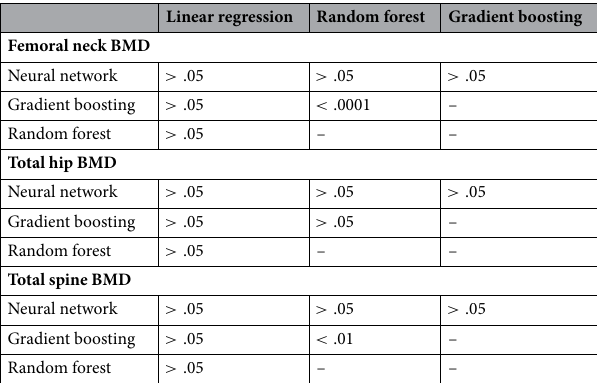
Table 2. Statistical comparisons of mean square errors in the testing dataset ( n = 1026 ) between various models when phenotype covariates and GRS were used as the predictors. The Wilcoxon Signed-Rank Test was used to determine all p values.